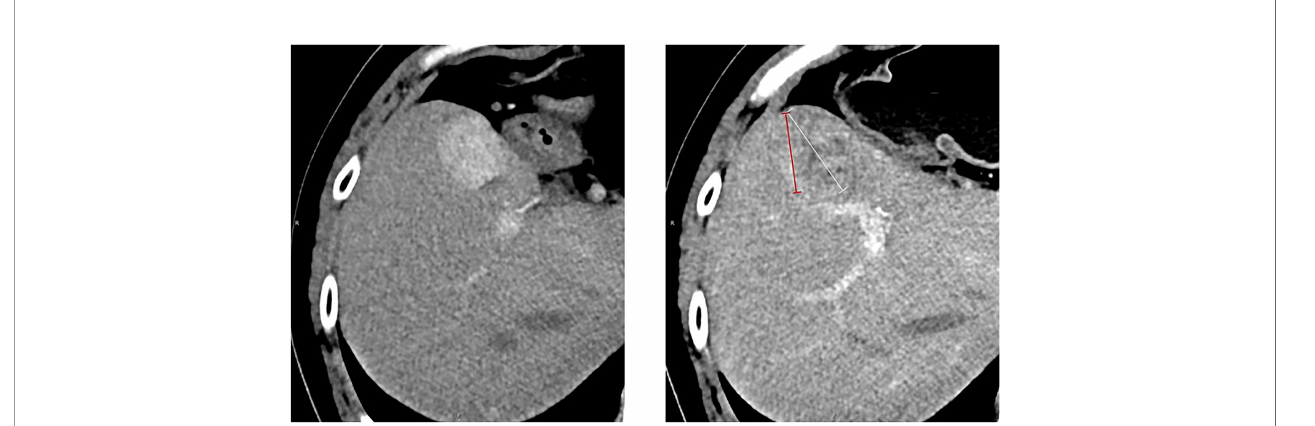
FIGURE 2 | Measurement of the longest tumor diameter in a target hepatic lesion: mRECIST vs. RECIST 1.1. Arterial-phase CT scan obtained after immunotherapy. According to RECIST 1.1, the overall longest diameter of the tumor is captured (white arrow), regardless of the presence of a large area of intratumoral treatment- induced necrosis. In contrast, mRECIST measurement (red arrow) only includes the longest diameter of the viable portion of the tumor, as recognized by contrast enhancement. A 54 ‐ year ‐ old man who had an arterial-phase CT examination before and after 27 cycles of immunotherapy. The baseline CT size of the target hepatic lesion was 30 mm (left). After immunotherapy, follow ‐ up CT (right) showed treatment response of previous lesions. The response was assessed as PD according to RECIST 1.1 (47 mm) and SD based on mRECIST (34 mm).